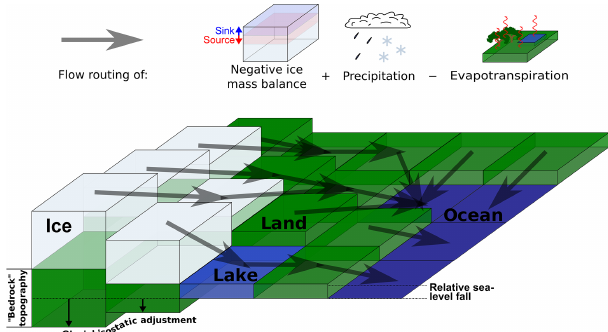
Figure 1. Meltwater and meteoric (precipitation minus evapotran- spiration) water are routed to the coast, across a surface formed by the sum of present-day topography, glacial isostatic adjustment, and ice-sheet